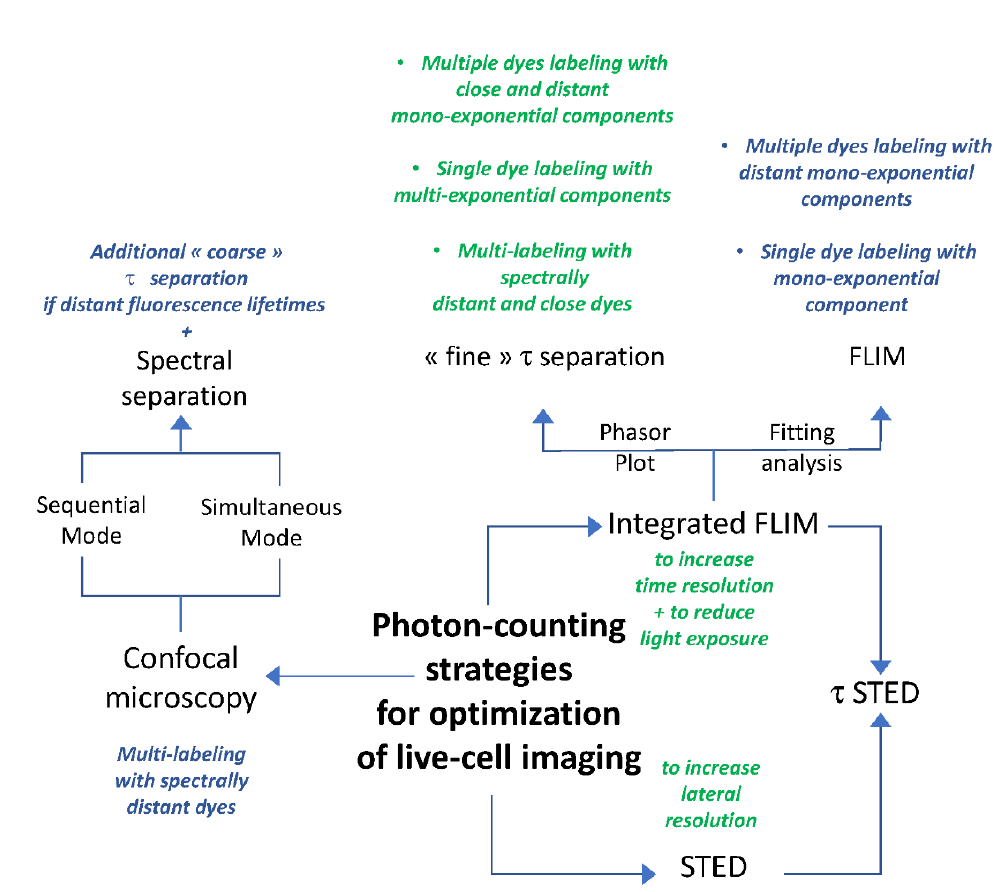
Figure 9. Photon-counting strategies for optimization of live-cell imaging. Agile method for selecting appropriate optimiza- tion of live-cell imaging with red/near-infrared dyes.